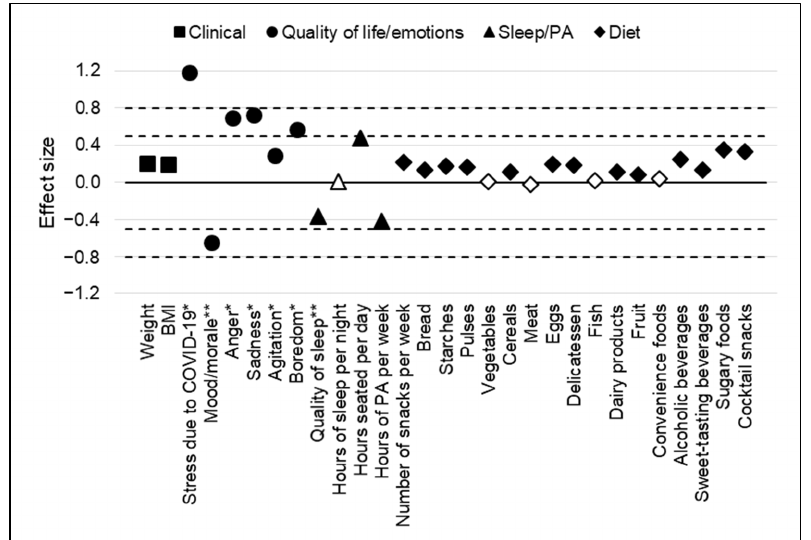
Figure 1. Effect sizes of the variation of each criterion before and during the first lockdown (between 17 March and 10 May 2020). Effect sizes are interpreted according to Cohen’s recommendations: 0.2 = small effect, 0.5 = medium effect, and 0.8 = large effect. Black symbols represent statistically significant effect sizes. White symbols represent statistically non-significant effect sizes. BMI: body mass index; PA: physical activity. * Visual analogue scale from 0 “minimum” to 100 “maximum.” ** Visual analogue scale from 0 “bad” to 100 “excellent”.